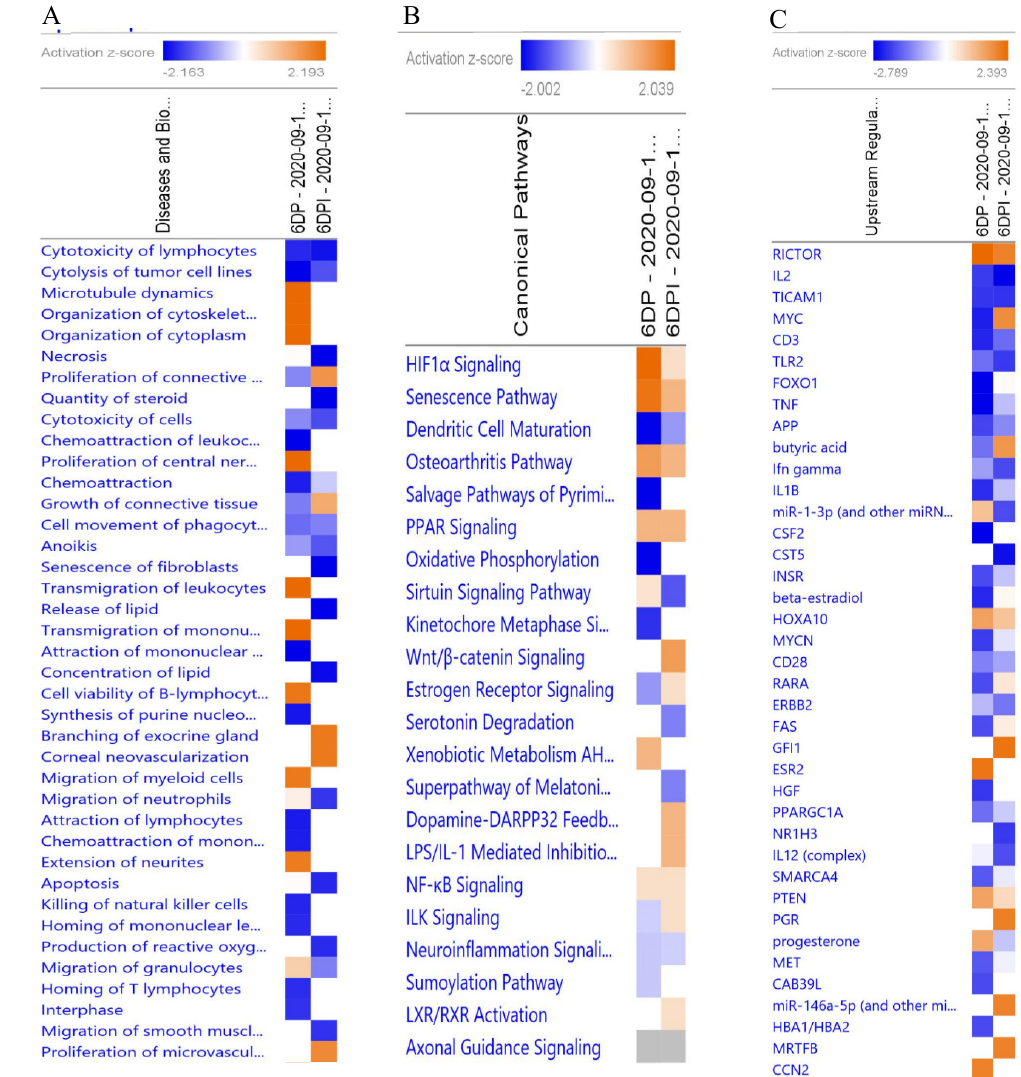
Figure 2. Comparison analysis of ( A ) diseases and bio functions, ( B ) canonical pathways, and ( C ) upstream regulators associated with DEGs identified on 6DP and 6DPI. A Z -score > 2 (orange color) is associated with activated functions, pathways, or upstream regulators and a Z -score < 2 (blue color) is associated with inhibited functions, pathways, or upstream regulators.